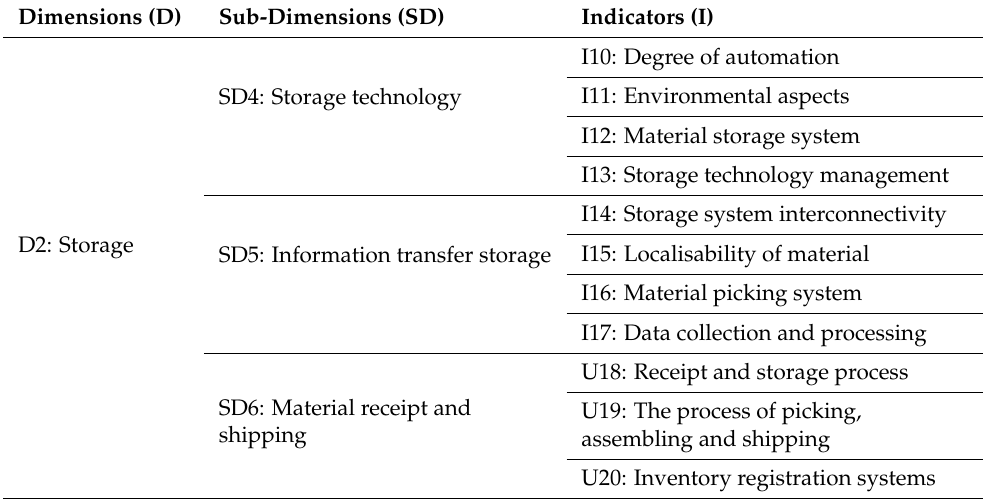
Table 5. Indicators for the dimension of D2: